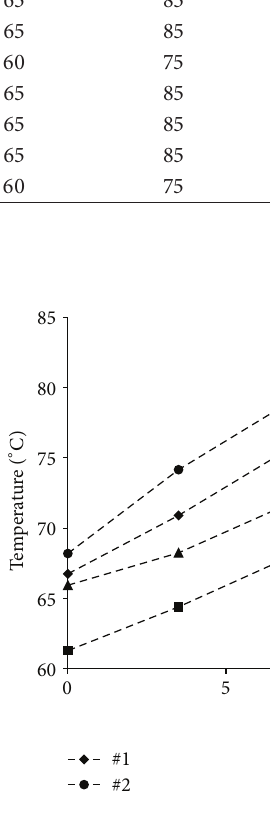
Figure 4: The imposed thermal profiles in the PHE (Sphere